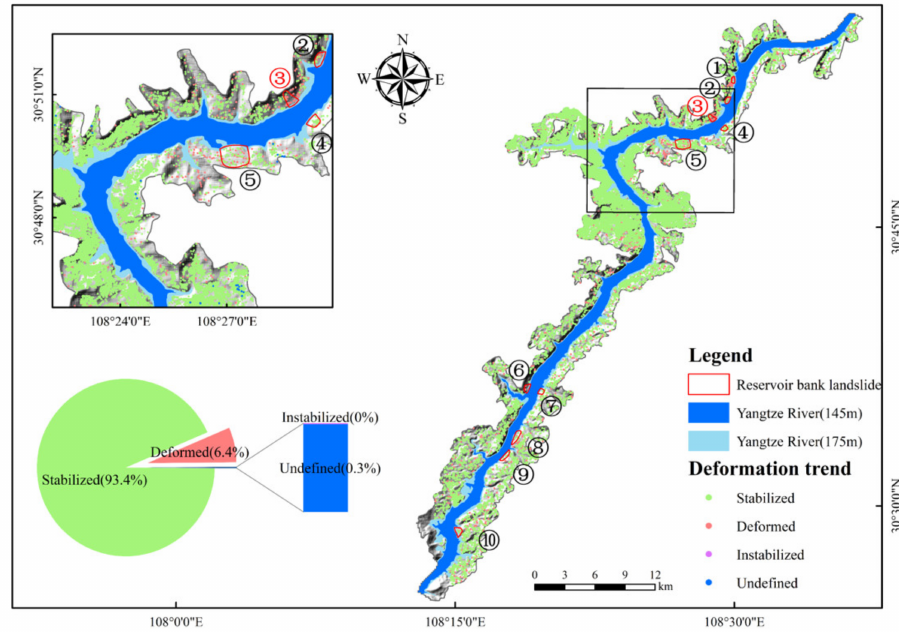
Figure 7. Predicted deformation trend of the reservoir bank slopes in the study area for the next four years ( 1 (cid:13) Laotangfang landslide; 2 (cid:13) Sharentian landslide; 3 (cid:13) Sifangbei landslide; 4 (cid:13) Xiangjiaping landslide; 5 (cid:13) Tangjiao landslide; 6 (cid:13) Rangduchangbei landslide; 7 (cid:13) Datangbang landslide; 8 (cid:13) Jinjinzi landslide; 9 (cid:13) Wuchiba landslide; and 10 (cid:13) Zhangjiacitang